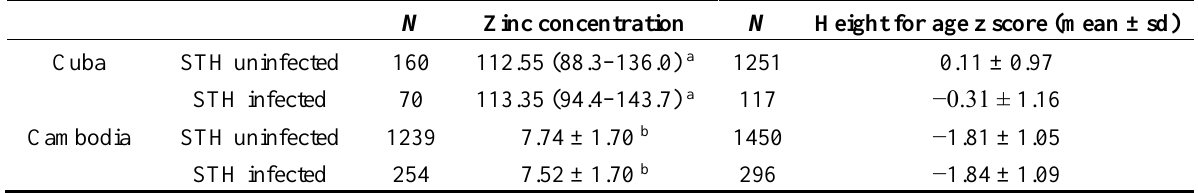
Table 2. Zinc and height for age in STH infected and uninfected